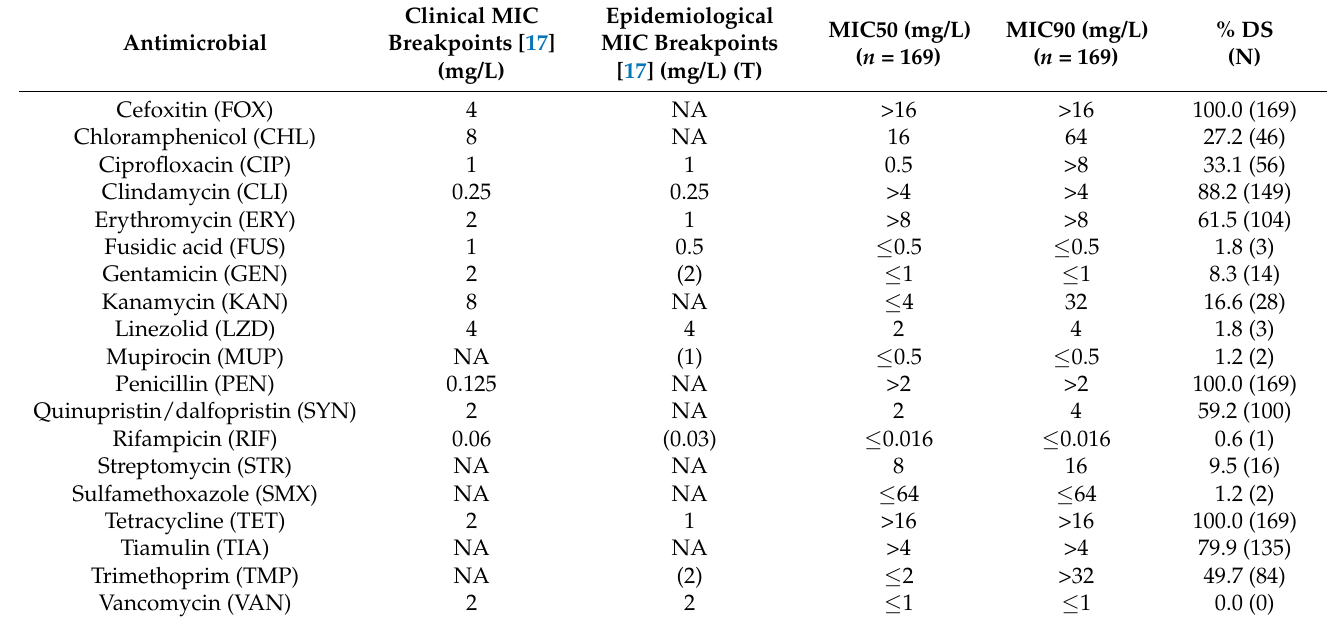
Table 1. Clinical and epidemiological breakpoints, MIC50, MIC90, and frequency of resistance of the MRSA